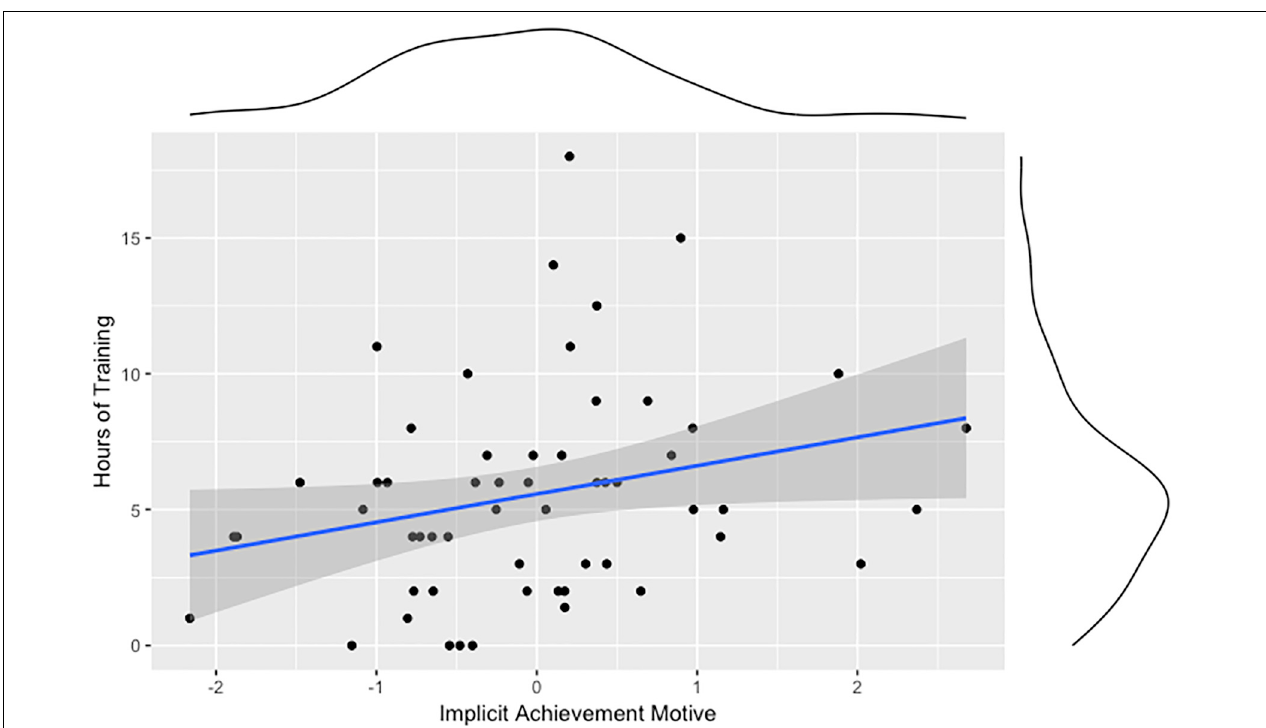
FIGURE 3 | Association between the implicit achievement motive and hours of training.